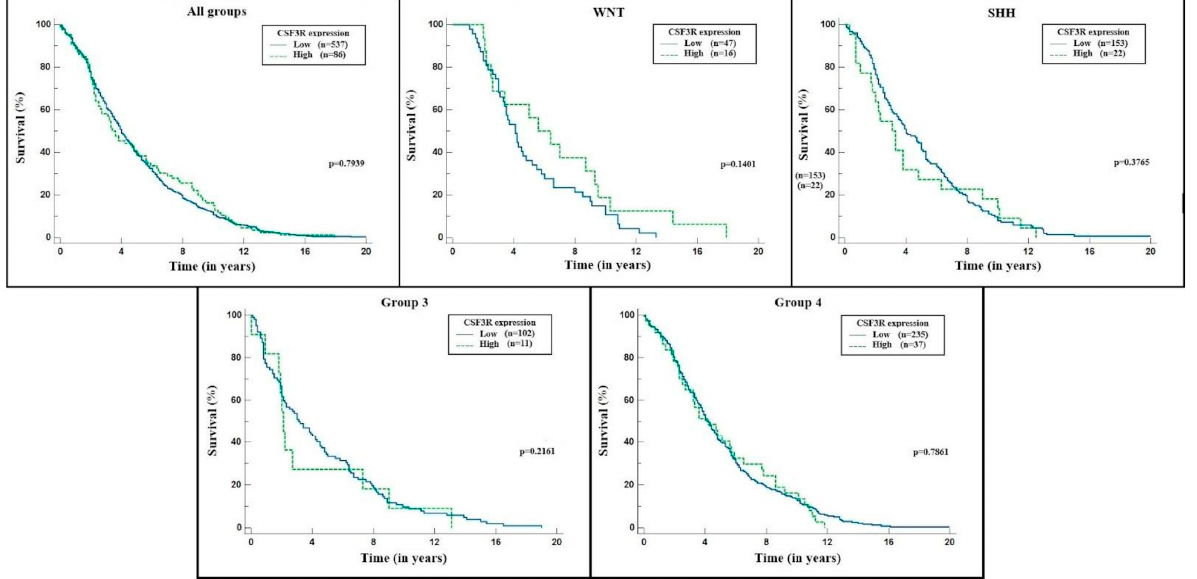
Figure 6. CSF3R expression × survival (75th percentile) for each molecular group and total sample. Source: the authors. Compiled using MedCalc ® version 20.115 (MedCalc Software Ltd., Ostend, Belgium).